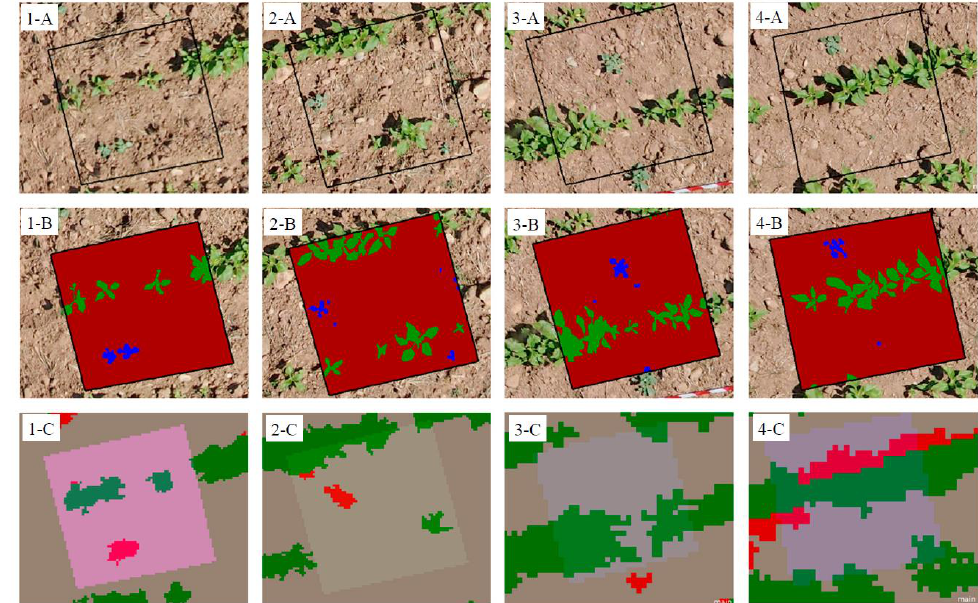
Figure 10. Example of the four sample frames ’ outcomes. ( A ) On-ground images; ( B ) manual clas- sification of observed data; and ( C ) image classification conducted by the OBIA algorithm. ( 1 ) Cor- rect categorization; ( 2 ) underestimation of weeds; ( 3 ) negative errors; ( 4 ) false positive errors